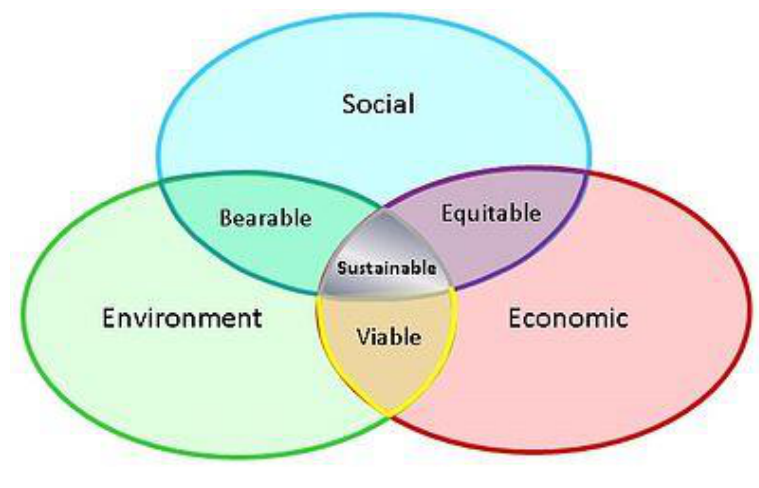
Figure 1: The Three Perspectives of Sustainable